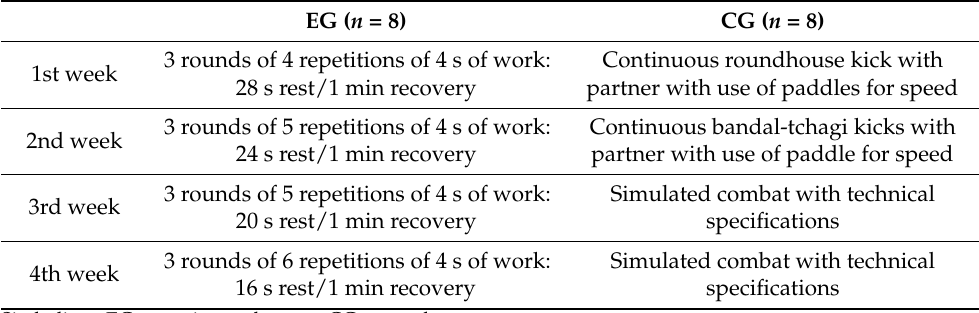
16 s rest/1 min recovery